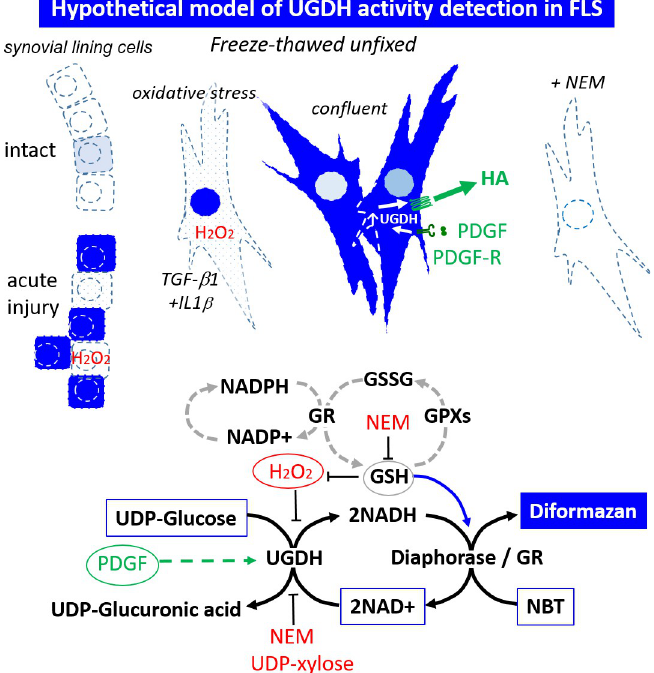
Fig 7. Hypothetical model representing 2-enzyme UGDH activity staining mechanisms in cultured cells and unfixed cryosections. Boxed molecules are enzyme staining components, encircled factors and dashed lines represent activities modulated in vivo by cytokines. Oxidative stress induced by inflammatory cytokines (TGF- β 1+IL-1 β ) can lead to peroxide generation and reversible inactivation of UGDH unless GSH scavenges the free radicals to sustain UGDH activity. High endogenous GSH can produce background staining by directly reducing NBT and by-passing UGDH. Abbreviations : PDGF: platelet derived growth factor; GR: glutathione reductase; GSH: glutathione; H 2 O 2 : peroxide; NEM: N-ethyl maleimide (thiol alkylating agent). In the upper panel, Dark blue cells: UGDH-stained cell compartments where cytosolic diaphorase, or nuclear glutathione reductase activity is present; dashed lines: freeze- thaw permeabilized cell